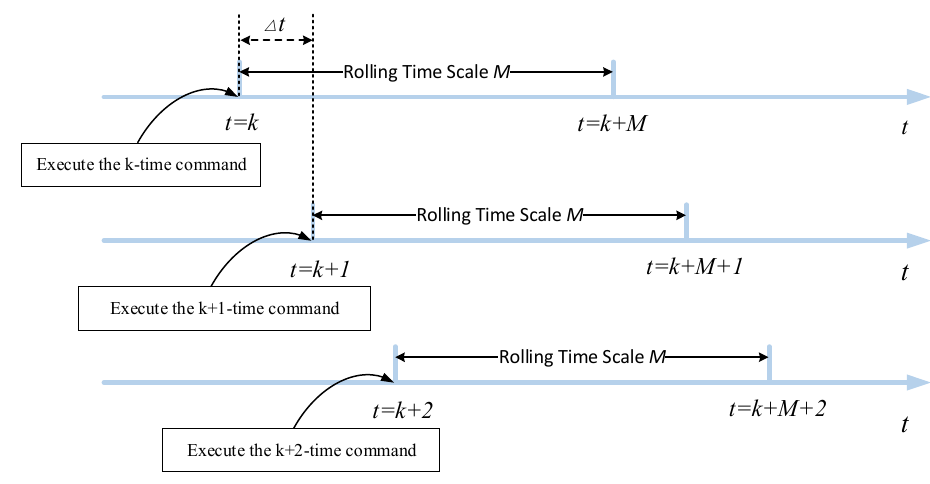
Figure 3. Rolling optimization time window.